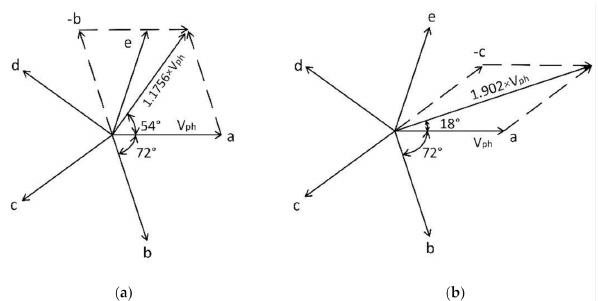
Figure 3. Phase diagram for five-phase source: ( a ) Mains voltage for adjacent phases (pentagon); ( b ) Mains voltage for non-adjacent phases